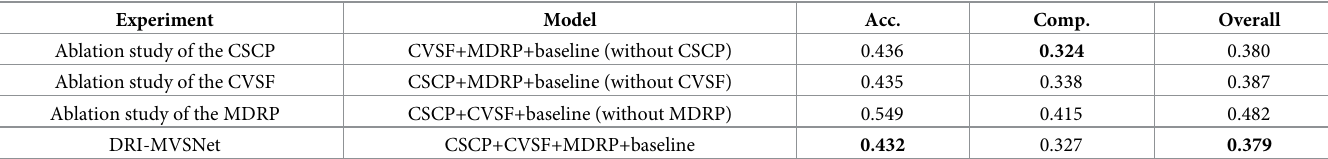
Table 4. Ablation study of the CSCP, CVSF, and MDRP on the DTU dataset. Experiment